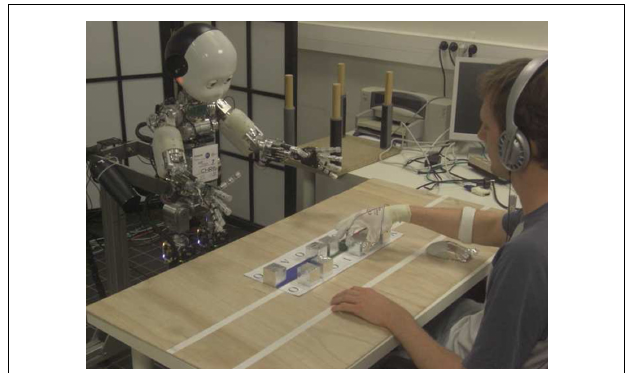
FIGURE 6 |The HRI setup. On the left side, the robot plays the role of the informer whereas the human is the manipulator. According to the conditions, the robot changes its behavior (see Figures 7A,C ). In order to observe a potential anticipation due to the eye and/or the head movement we measure the reaction time (RT) and the movement time (MT).The RT is the duration between the end of the speech location signal ( Figure 2 part (e)) and when the human lifts her/his hand from the initial position (on the picture under the elbow).The MT is the duration between the end of the speech location signal and the first manipulator cube contact (details in Figure 7D ). See Figure 1 for timeline.